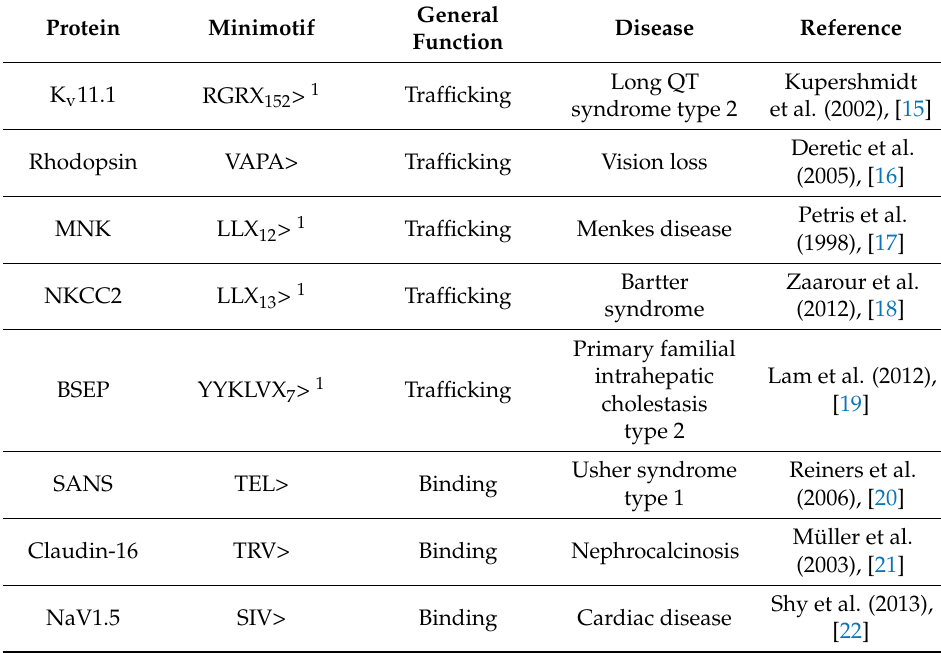
Table 1. Eight known C-terminal motifs in